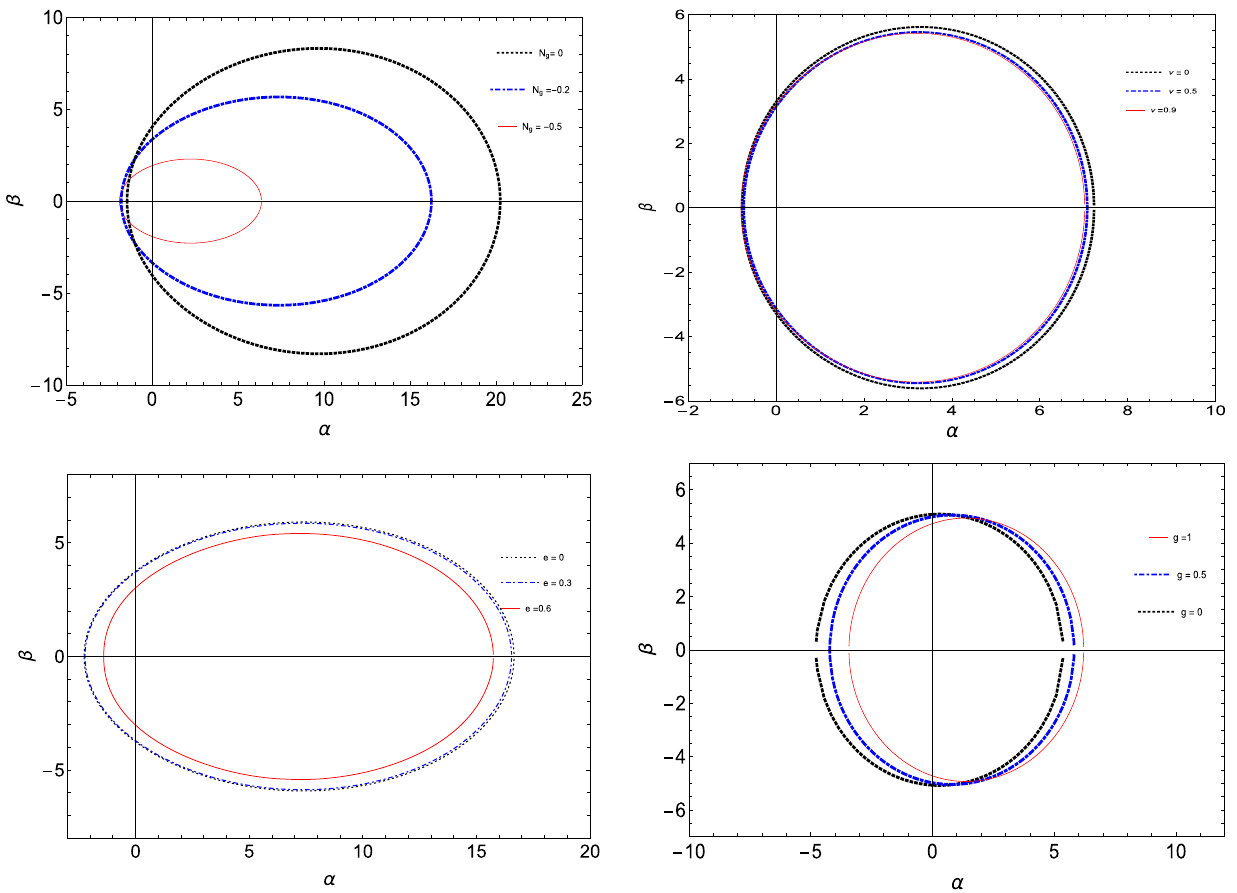
Fig. 2 The variation in photon rings for different values of NUT charge N g (top left), magnetic charge ν (Top right), electric charge e (bottom left) and gauge coupling constant g (bottom right) M =